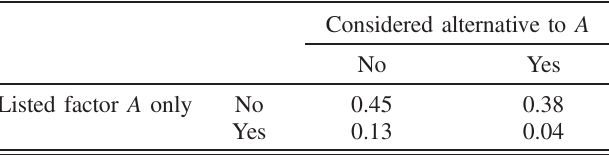
TABLE XIII. Experiment 4 average proportion of times par- ticipants did (or did not) consider an alternative explanation when factor A was provided as explanation, for participants who listed (or did not list) explanation A only in the recall task. This includes 102 participants answering 6 scenarios each.